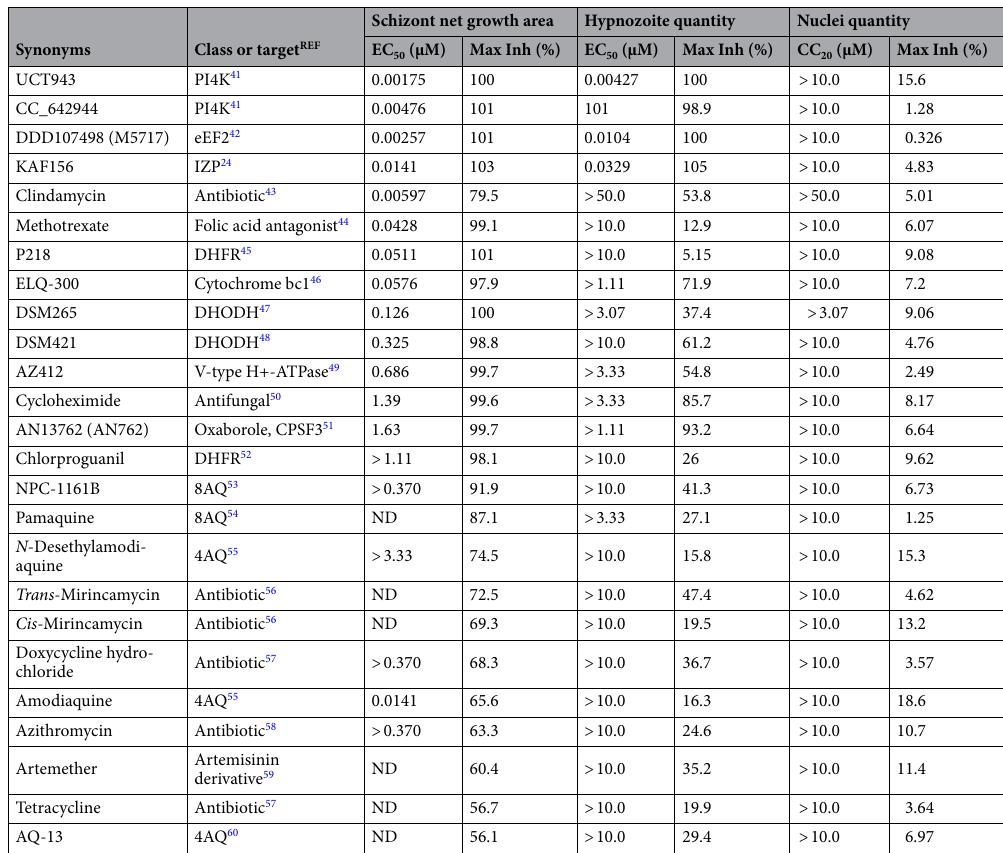
Table 1. Confirmed hits from 6-day prophylactic assays of the reference compound library. All EC 50 ’s, CC 20 ’s, and Maximum Inhibition (Max Inh) values are from the highest quality independent experiment. RCL, Reference Compound Library; PI4K, phosphatidyl inositol 4-kinase; eEF2, elongation factor 2; IZP, imidazolopiperazine; DHFR, dihydrofolate reductase; DHODH, dihydroorotate dehydrogenase; CPSF3, cleavage and polyadenylation specificity factor subunit 3; 8AQ, 8-aminoquinoline; 4AQ, 4-aminoquinoline. Included are activity values for selective compounds; activity data for selective and nonselective compounds, as well as structures, can be found in Supplementary Table S1